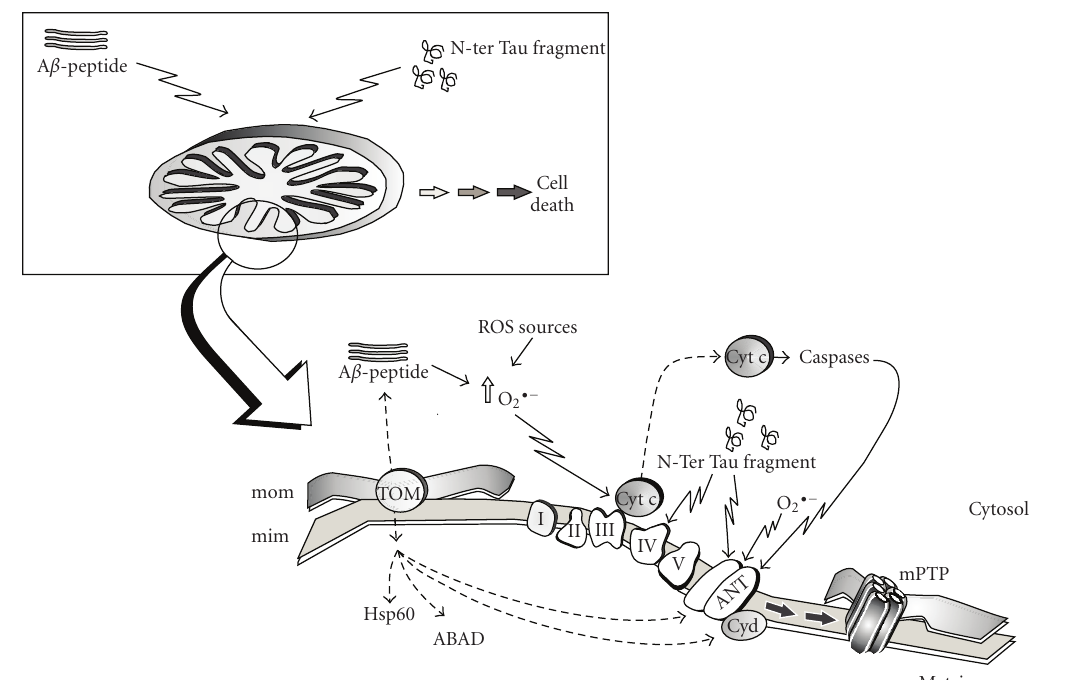
Figure 2: Proposed mechanism of A β peptide and N-ter Tau fragment interaction with mitochondria; for further details see text. mom , mito- chondrial outer membrane; mim , mitochondrial inner membrane; TOM , translocase of the outer membrane; I–V , respiratory chain com- plexes; cyt c , cytochrome c ; ANT , adenine nucleotide translocator; CyD , cyclophilin D; mPTP , mitochondrial permeability transition